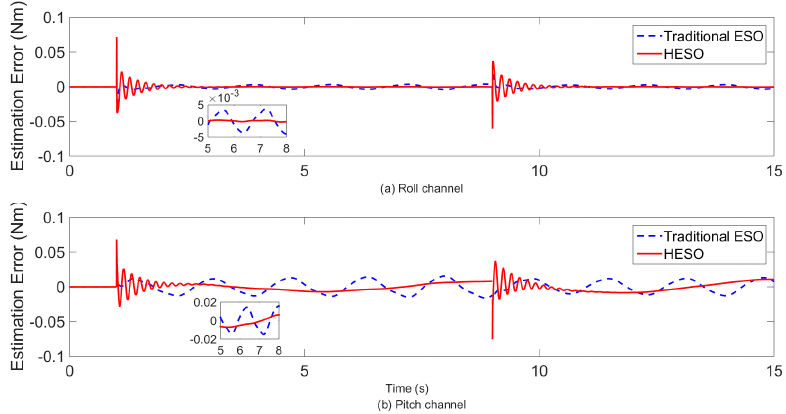
Figure 9. Estimation errors comparison of HESO and traditional ESO in attitude tracking.